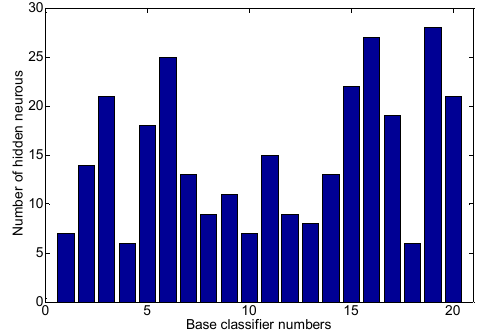
Figure 11. The number of hidden neurons in the base classifiers.